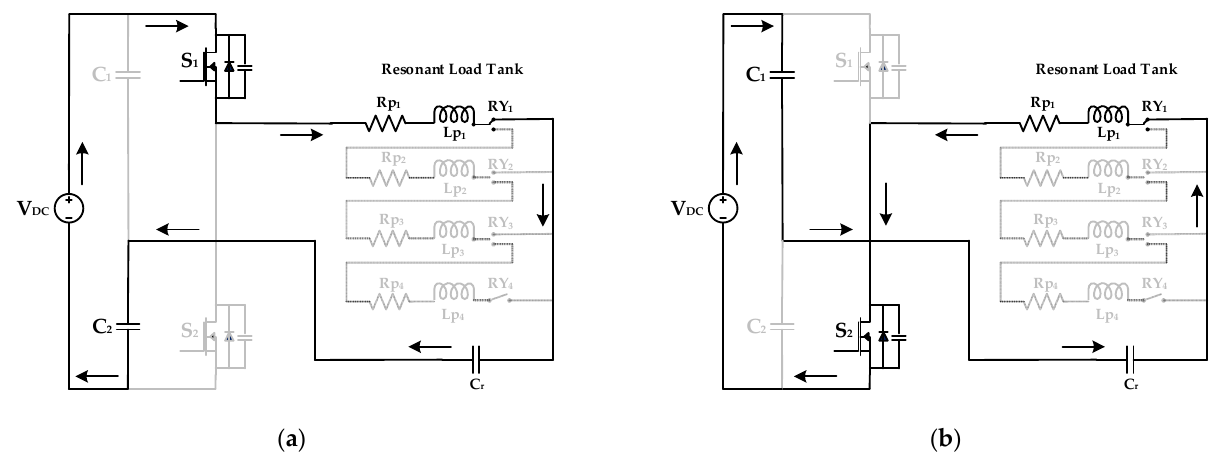
Figure 3. Circuit diagram of Mode 1: ( a ) Switch S 1 in ON state; ( b ) Switch S 2 in ON state.